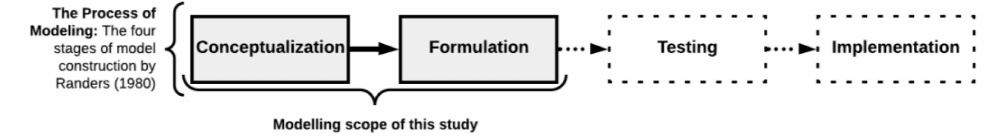
Figure 1. Randers’ modeling methodology.